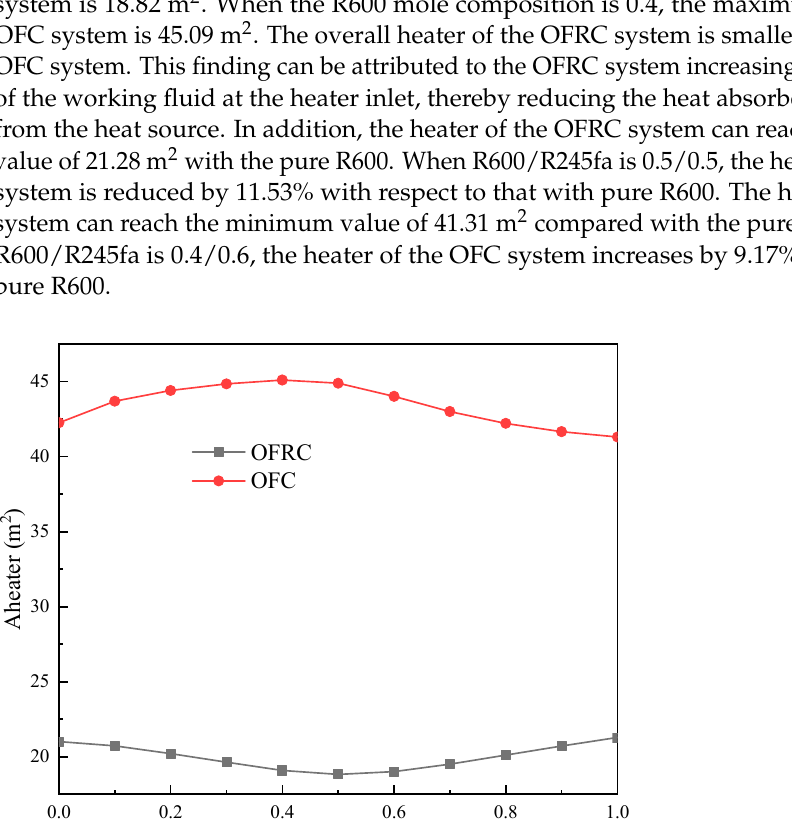
14 of 19 Figure 10. Variation of the exergy loss ratio of circulating components with the R600 mole fraction. Figure 11 shows the change in the heat exchange area of the system heater with the R600 mole composition utilized under optimized operating conditions. With the increase in R600 mole components, the heater of the OFRC system showed a trend of initial decrease followed by an increase, whereas the heater of the OFC system showed an